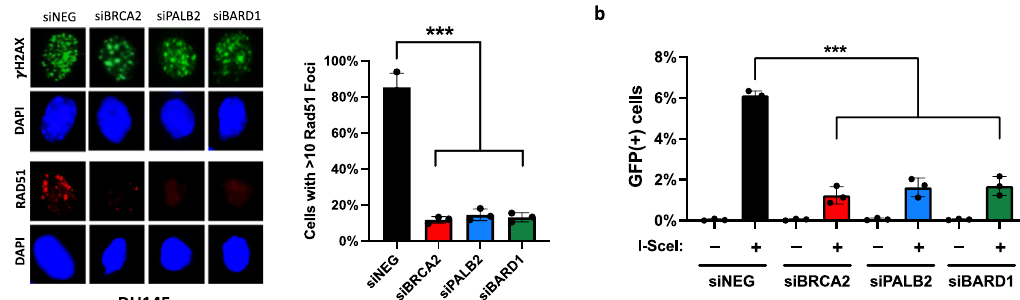
Fig. 2 PALB2 or BARD1 loss confers homologous recombination (HR) de fi ciency in prostate cancer cells. a Immuno fl uorescence analysis showing decrease in radiation-induced RAD51 foci formation in PALB2- and BARD1-depleted prostate cancer cells. All cells form γ H2AX foci following radiation, but cells with PALB2 or BARD1 depletion have signi fi cantly decreased number of Rad51 foci compared to mock-depleted cells (siNEG). BRCA2-depleted cells are included as a control for HR de fi ciency. b Homologous recombination ef fi ciency as measured by the DR-GFP reporter assay. HR-mediated repair of an induced double-strand break is signi fi cantly lower in PALB2- and BARD1-depleted cells compared to mock-depleted cells (siNEG). BRCA2-depleted cells are included as a control for HR de fi ciency. See Supplementary Fig. 4 for FACS gating strategy. IR ionizing radiation. GFP green fl uorescent protein. HR homologous recombination. Error bars represent the standard deviation of three independent experiments. *** p <